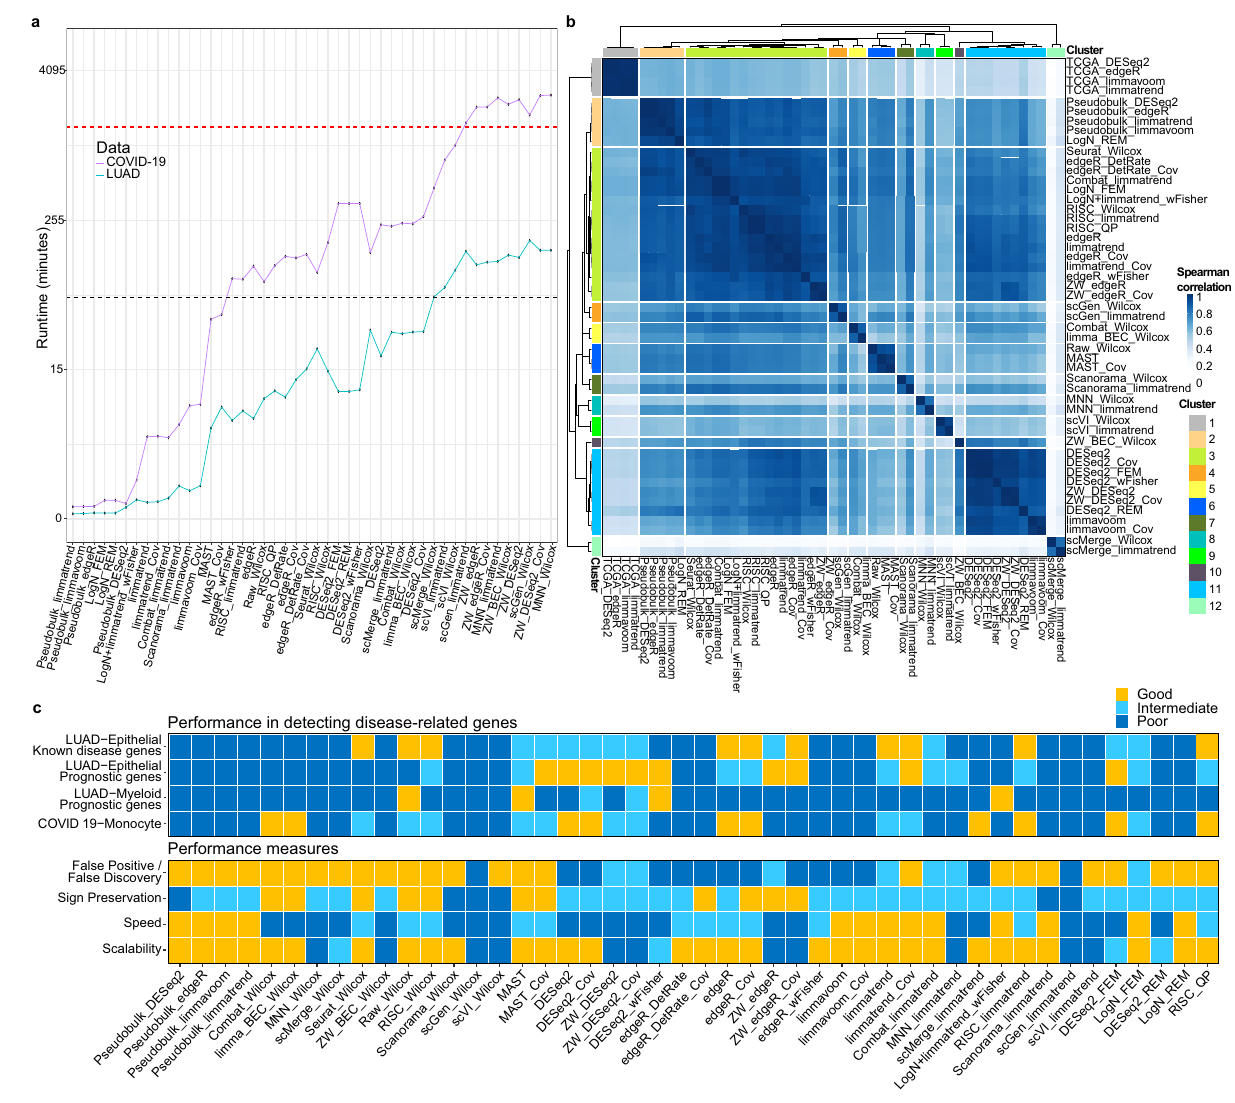
Fig. 7 | Comparison of runtimes, similarity of differential expression (DE) work fl owsandothermeasures.a CPUtimes(log-scale)ofDEwork fl owstakenfor analyzing lung adenocarcinoma (LUAD) epithelial cell ( n =7728) and COVID-19 monocyte ( n =100361) scRNA-seq data, each containing 10278 and 7242 genes, respectively. b Clusteringheatmapof46DEwork fl owsforLUADepithelialcelldata